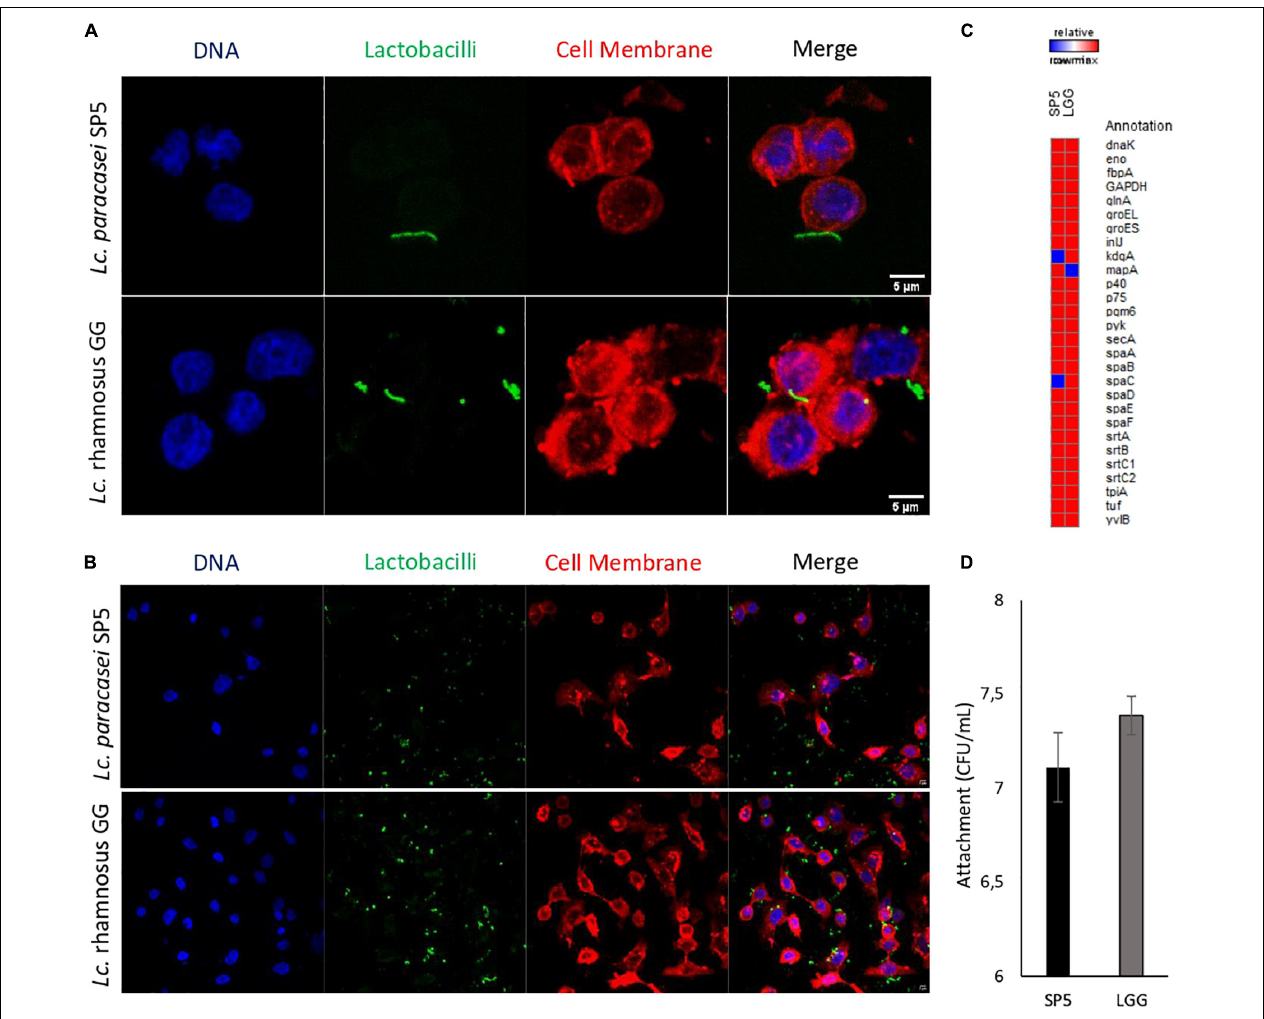
FIGURE 7 | Evaluation of the adhesion capacity of Lc. paracasei SP5 onto the human colon cancer adenocarcinoma cell line, HT-29. (A,B) Representative photos from confocal fluorescent microscopy showing the adhesion capacity of Lc. paracasei SP5 or Lc. rhamnosus GG. Panel A represents a zoomed in image of a 40x photo, edited by ImageJ (version 1.53f51), while panel B represents a photo of the original magnification (40 × ). Bacteria are stained with CFSE (green), eukaryotic nuclei (blue) and cell membranes (red) are stained with Hoescht and CellBrite Red Cytoplasmic Membrane Dye, respectively (scale bar, 5 µ m). (C) Gene matrix depicting the presence or absence of adhesion-related proteins in the genomes of Lc. paracasei SP5 and Lc. rhamnosus GG, annotated by PGAP. (D) Determination of attached bacterial counts (CFU/mL) of Lc. paracasei SP5 (black bar) or Lc. rhamnosus GG (grey bar) after 4 h co-incubation with HT-29 monolayers. Results are presented as mean ± standard